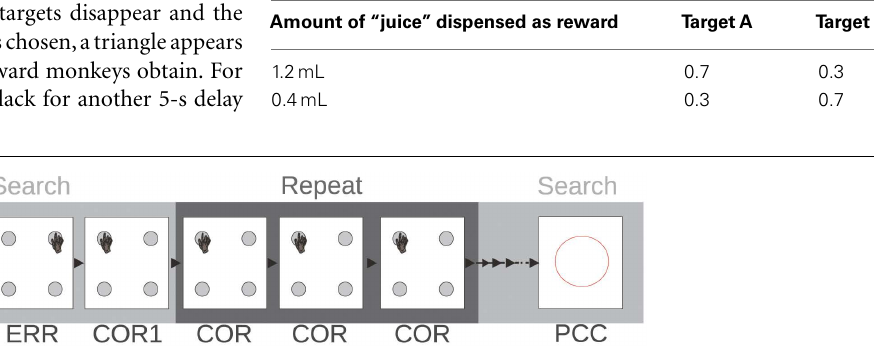
Table 1 | Reward probabilities used in Experiment 2.